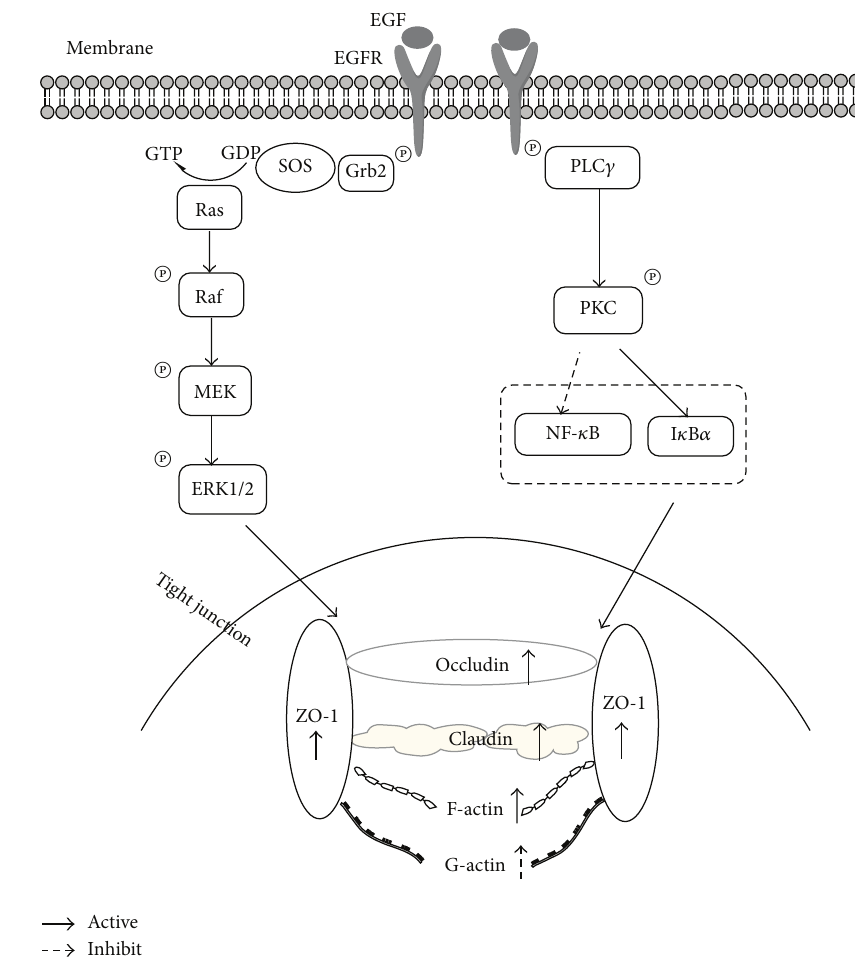
Figure 2: The EGFR-phospholipase (PLC)- 𝛾 -PKC and EGFR-ERK/MAPK signaling pathways are involved in EGF-mediated protection of tight junctions. ERK/MAPK pathways were mainly involved in regulating barrier function by improving the gene expression of tight junction proteins such as ZO-1, claudin-1, and occludin, while PLC- 𝛾 -PKC pathways were mainly involved in regulating actin cytoskeletal architecture such as F-actin and